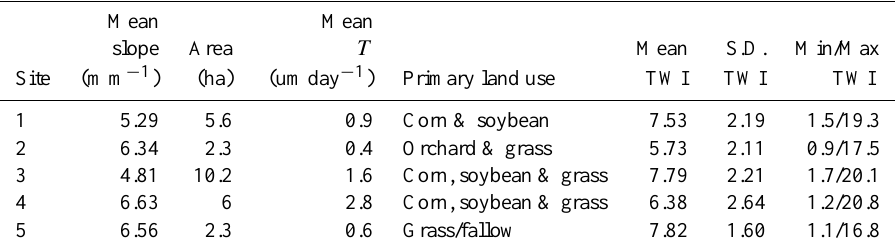
Table 1. Soil, topographic and land use characteristics of each study site. Average transmissivity values were derived from SSURGO soil data (USDA-NRCS,